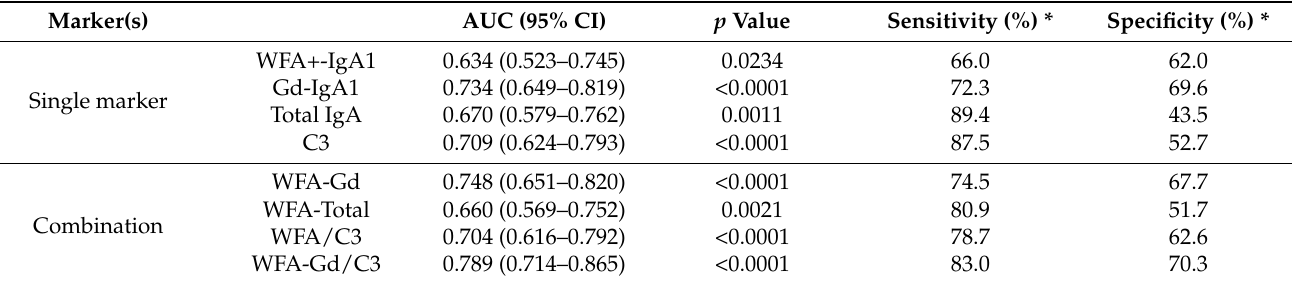
Table 2. Comparative analysis of single and combined markers for IgAN